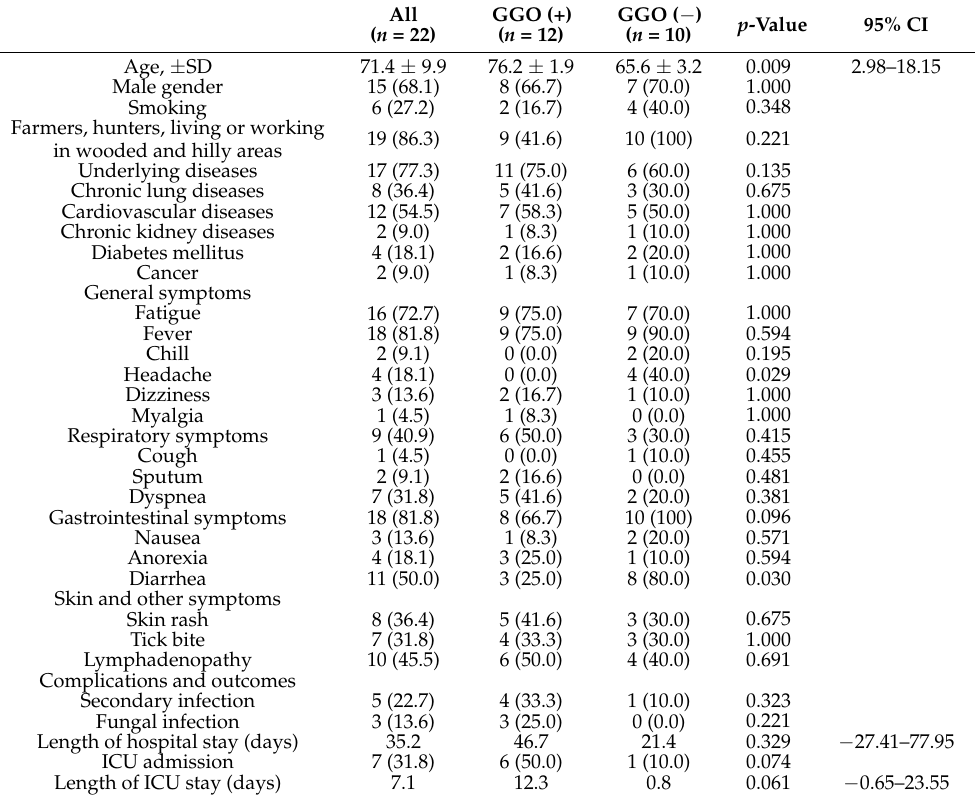
Table 3. Underlying conditions, symptoms, and outcomes in patients with